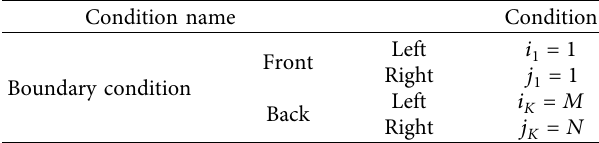
Table 1: The relationship between various boundary